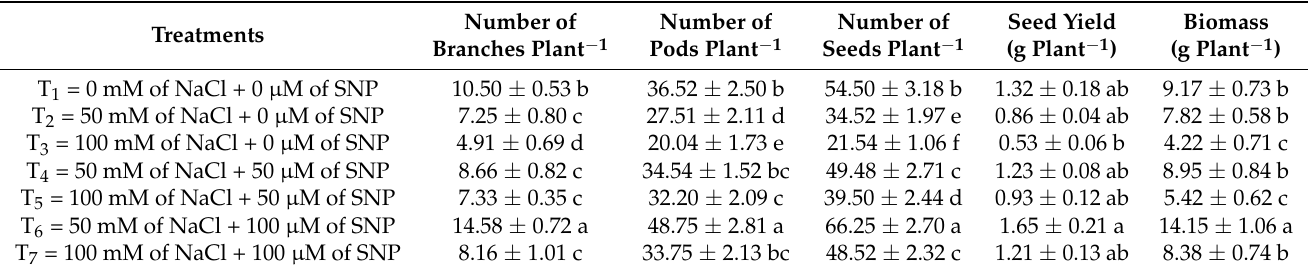
Table 2. Effect of SNP on the yield attributes of lentils grown under different levels of NaCl.